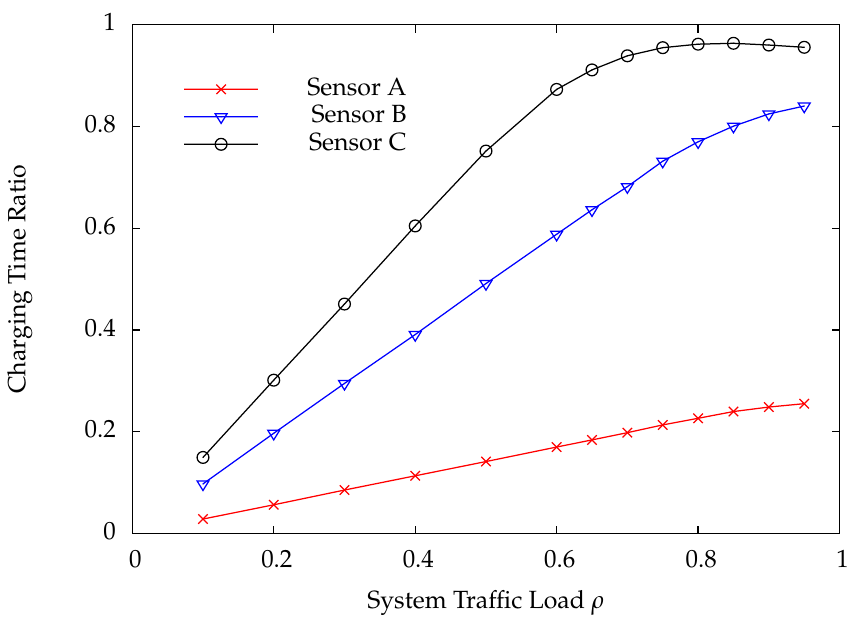
Figure 12. Charging time ratio versus system traffic load ρ